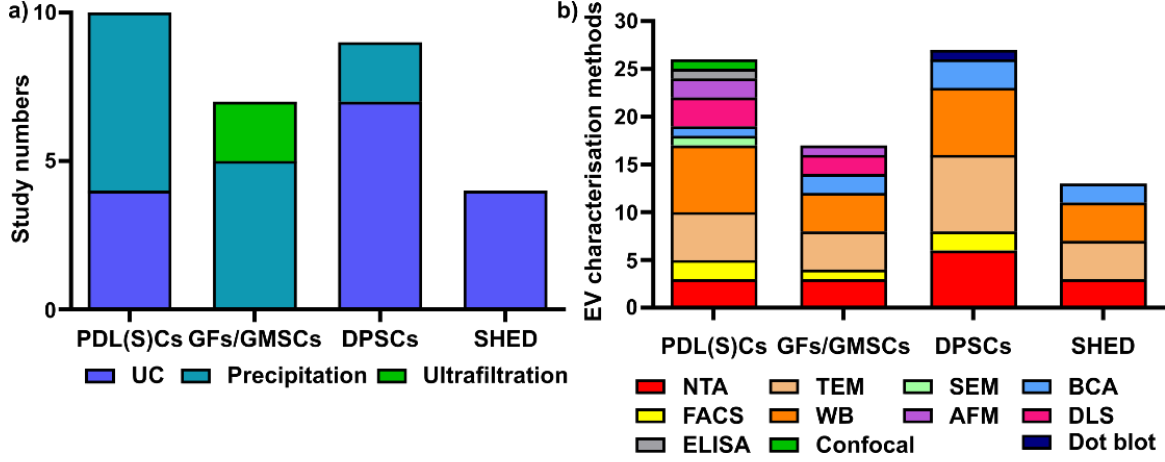
Figure 3. Various sEV isolation methods ( a ) and characterization methods ( b ) are used for periodontal (dental pulp) cells. UC: ultracentrifugation; NTA: nanoparticle tracking analysis; TEM: transmission electron microscopy; WB: Western blot; SEM: scanning electron microscopy; AFM: atomic force microscopy; BCA: bicinchoninic acid assay; DLS: dynamic light scattering; ELISA: enzyme-linked immunosorbent assay; confocal: confocal microscopy.